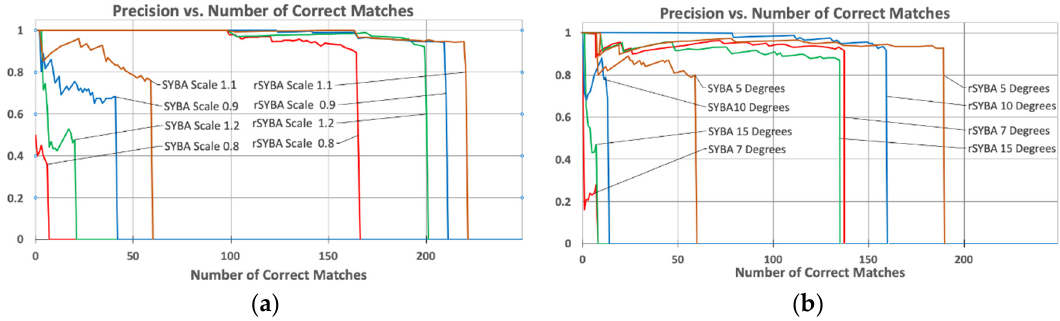
Figure 8. Precision comparison of SYBA and rSYBA for the ( a ) scaling and ( b ) rotation variations.